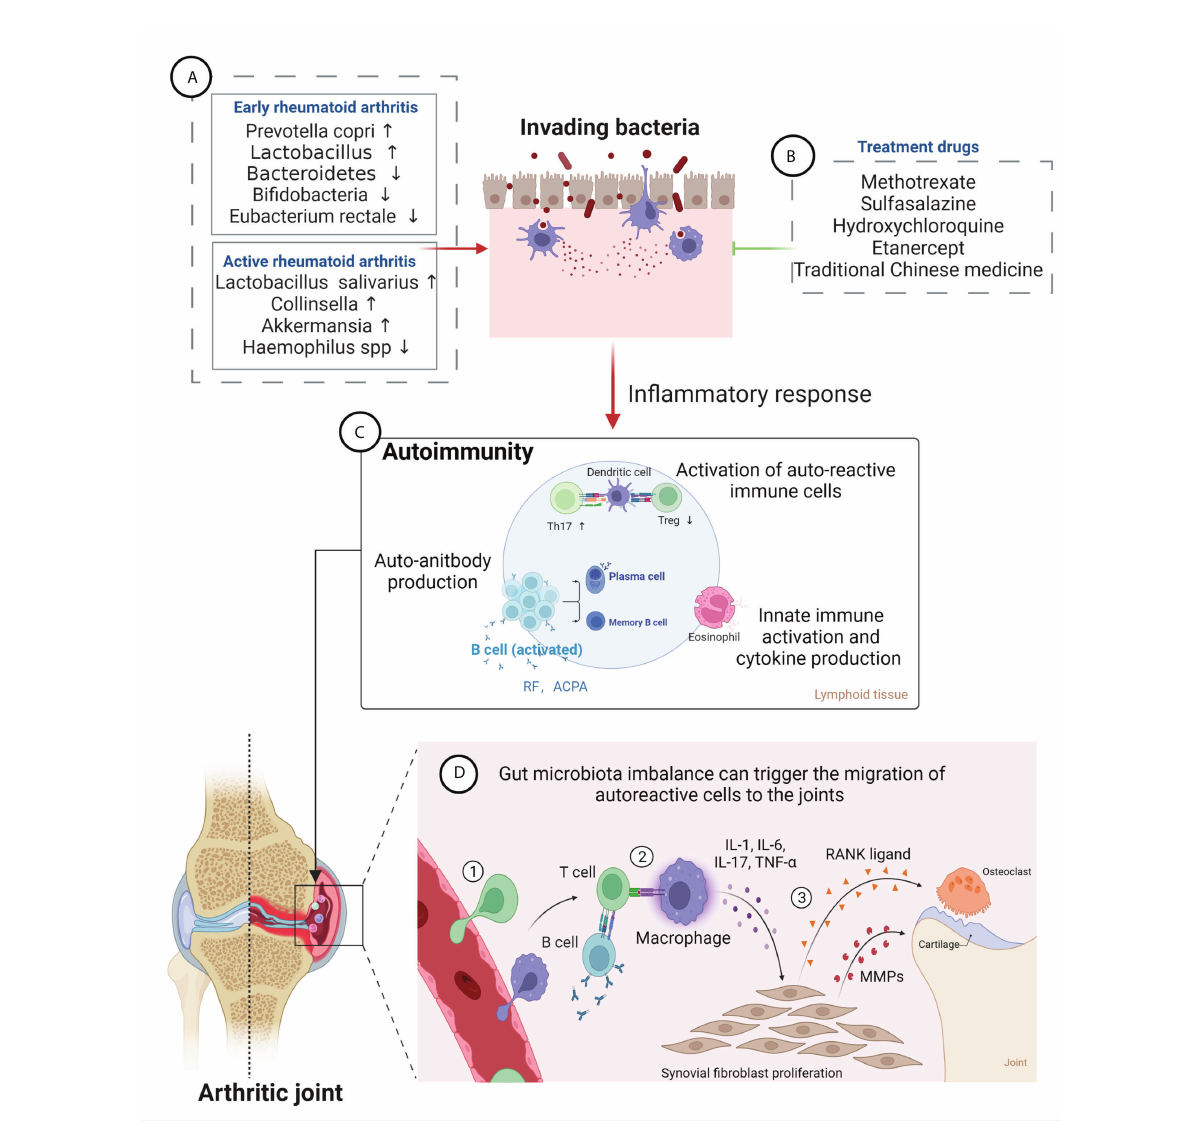
FIGURE 1 Gutmicrobiotainthepathogenesisofrheumatoidarthritis(RA)andeffectsofRAtherapeuticdrugsonthegutmicrobiota. (A) Changesinthecompositionof gutmicrobiotaatdifferentstagesofRA.Levelsof Prevotellacopri and Lactobacillus areincreased,whilethoseof Bacteroidetes,Bi fi dobacteriaandEubacterium rectale aredecreased,atanearlystage;Abundanceof Lactobacillussalivarius , Collinsella ,and Akkermansia isincreased,whilethatof Haemophilus spp.is decreased,intheactiveRAphase. (B) RAtreatmentdrugscanimprovegutmicrobiotaimbalanceandrelievediseasesymptoms,mainlyincludingmethotrexate, sulfasalazine,hydroxychloroquine,etanercept,andtraditionalChinesemedicine. (C) Gutmicrobiotacanleadtodamageoftheepitheliumandtotheopening oftheparacellularpathwayandcancrosstheepitheliumandgetincontactwiththeimmunecellsbeneaththeepitheliallayer,whichleadstoin fl ammation. Furthermore,bacterialantigenspromoteactivationofautoreactiveimmunecells(BcellandTcell)inthelymphoidtissues,resultinginanimbalancebetween regulatoryTcells(Tregs)andThelper17(Th17)cells,leadingtoexpansionofin fl ammatoryresponse.ActivatedBcellsproduceautoantibodies(anti-citrullinated proteinantibodyandrheumatoidfactor). (D) Gutmicrobiotaimbalancecantriggerthemigrationofautoreactivecellstothejoints,causingcartilageandbone damage. ① Bacterialantigenstriggerpromotesin fl ammationinsynovialmembrane,attractingleukocytesintothetissue. ② Autoreactivecellsactivate macrophages,resultinginin fl ammatorycytokineproduction. ③ Cytokinesinduce fi broblaststoproduceMMPs(matrixmetalloproteinases)andRANKL (receptoractivatorofnuclearfactor k